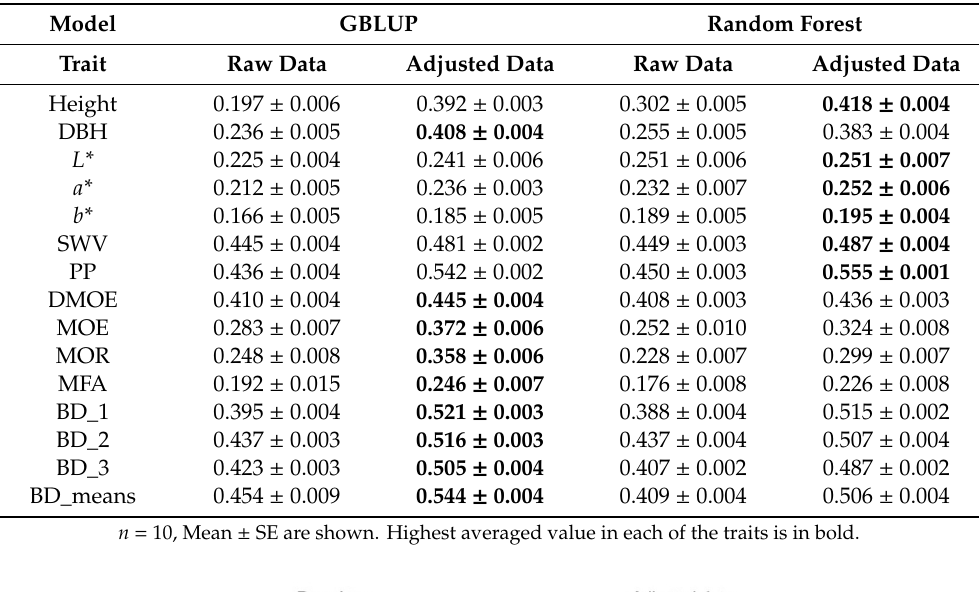
Table 2. Correlation coefficients for the genomic prediction models in the F 1 population. BD: basic density, DBH: diameter at breast height, DMOE: dynamic Young’s modulus, GBLUP: genomic best linear unbiased prediction, MFA: microfibril angle, MOE: modulus of elasticity, MOR: modulus of rupture, PP: pilodyn penetration depth, SWV: stress wave velocity.